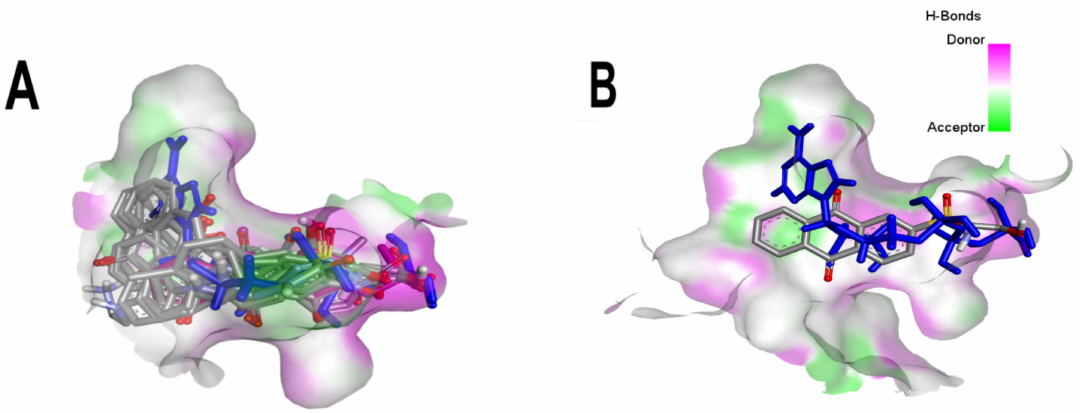
Figure 1. Superposition of the best poses of the best-scored anthraquinones compared to the crystal- lographic pose of ANP in the catalytic site of Mt GyrB. ( A ) Superposition of the ten best poses of the best-scored anthraquinones compared to the crystallographic pose of ANP. ( B ) Superposition of the best-scored one (BS-1) anthraquinone compared to the crystallographic pose of ANP. BS-1 (7122772), BS-2 (85992490), BS-3 (3794639), BS-4 (133109345), BS-5 (94940647), BS-6 (108793505), BS-7 (7122774), BS-8 (625367), BS-9 (100282) and BS-10 (123132836). ANP (33113) is highlighted in dark blue. 3D hydrogen bond surface representation was performed with Discovery Studio